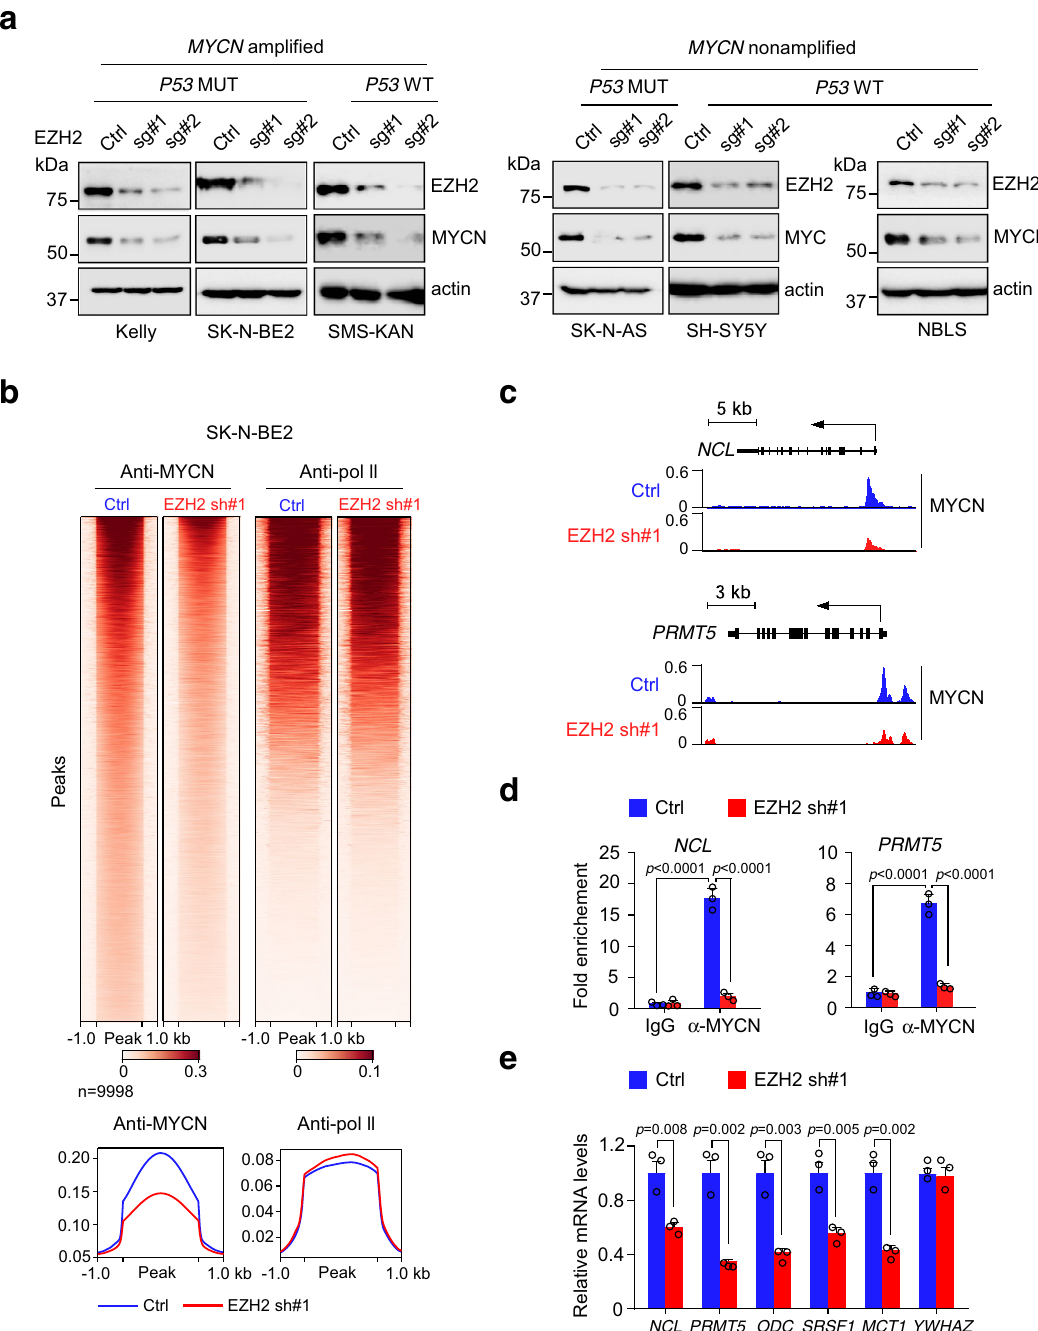
Fig. 2 EZH2 de fi ciency decreases MYCN and MYC expression and transcriptional activity in neuroblastoma cells. a Immunoblot to detect MYCN or MYC levels upon EZH2 depletion with speci fi c sgRNAs in MYCN -ampli fi ed (Kelly, SK-N-BE2 and SMS-KAN) and MYCN -nonampli fi ed (SK-N-AS, SH-SY5Y and NBLS) neuroblastoma cells. Actin was used as a loading control. The experiments were independently repeated three times with similar results. b Heatmap presentation of genome-wide MYCN and pol II occupancies in MYCN -amplifed SK-N-BE2 cells analyzed by ChIP-Seq. c Genome browser views of MYCN occupancy in the NCL and PRMT5 loci in SK-N-BE2 cells with or without EZH2 depletion. d Binding of MYCN to the NCL or PRMT5 promoter was analyzed by ChIP-qPCR in SK-N-BE2 cells with or without EZH2 depletion. Averages of fold enrichment between anti-MYCN and the isotype IgG control are shown. Graph shows mean ± SD from triplicates; signi fi cance was determined by two-way ANOVA test followed by Tukey ’ s correction. e Real-time qPCR analysis of representative MYCN target genes in SK-N-BE2 cells upon EZH2 depletion. Graph shows mean ± SD from triplicates; signi fi cance was determined by unpaired two-tailed Student ’ s t -test. Source data are provided as a Source data fi